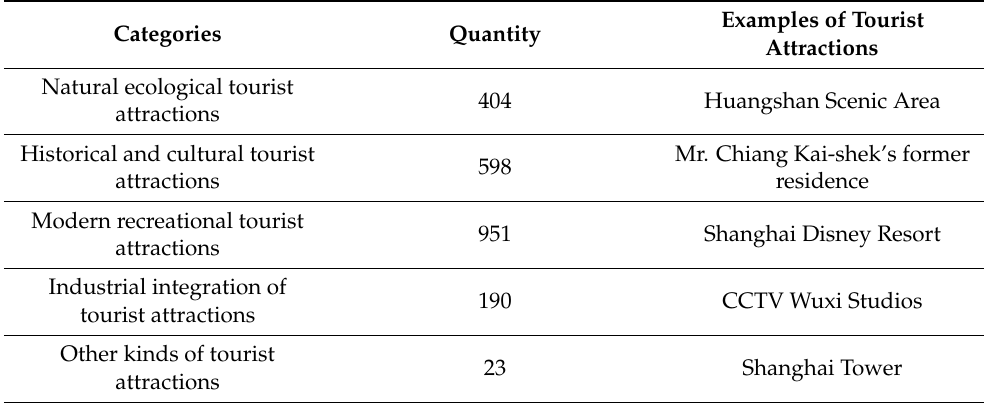
Table 1. Types of tourist attractions in the Yangtze River